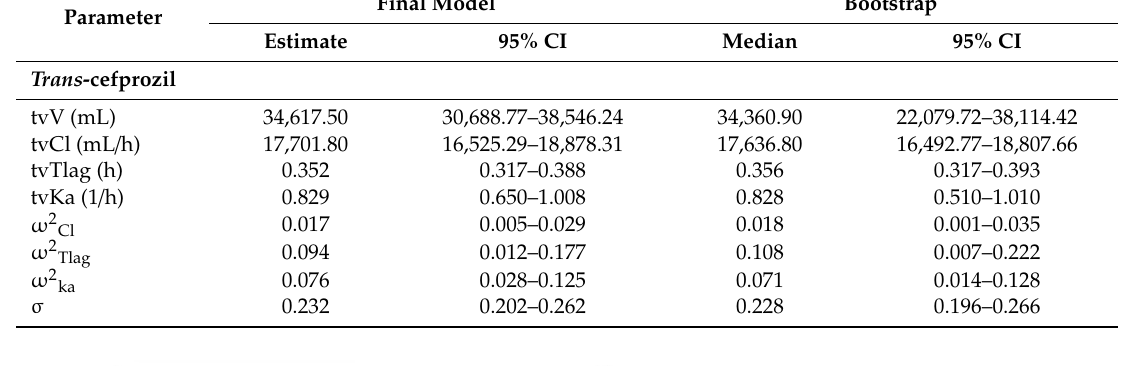
Figure 3. Goodness-of-fit plots of base model ( A ) and final model ( B ) for trans -cefprozil. ( a ) Observed plasma concentrations (DV) against population predicted concentrations (PRED); ( b ) Observed plasma concentrations (DV) against individual predicted concentrations (IPRED); ( c ) Conditional weighted residuals (CWRES) against population predicted concentration (PRED); ( d ) Conditional weighted residuals (CWRES) against time (IVAR); ( e ) Quantile-quantile plot of components of conditional weighted residuals.